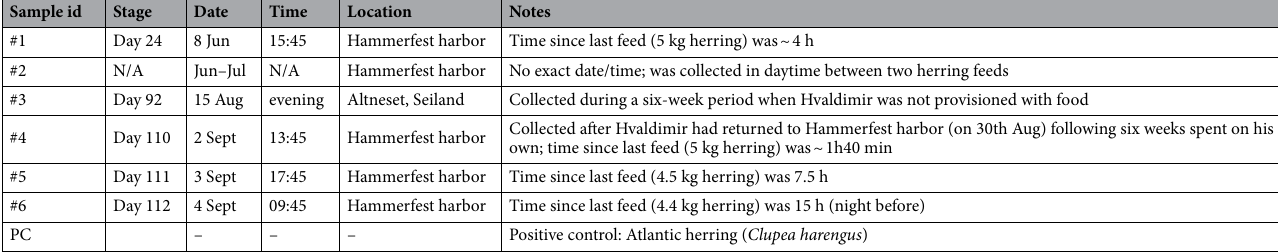
Table 1. Information related to sampling of Hvaldimir’s fecal pellets between June and September 2019 in northern